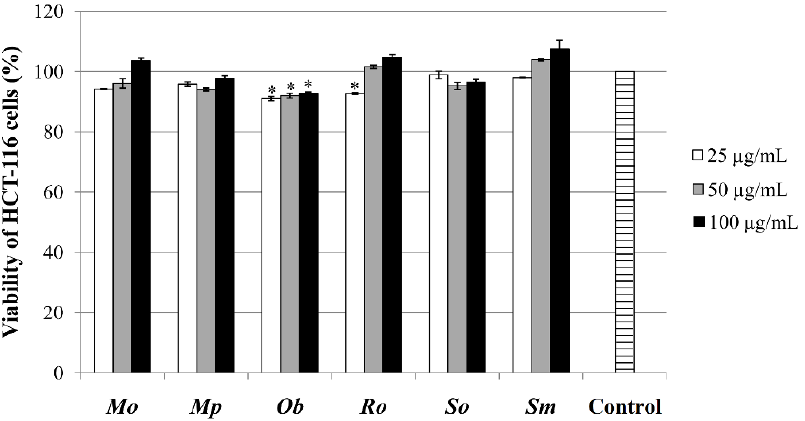
Figure 4. MTT assay performed in the extracts’ concentrations of 25, 50, and 100 µg/mL.